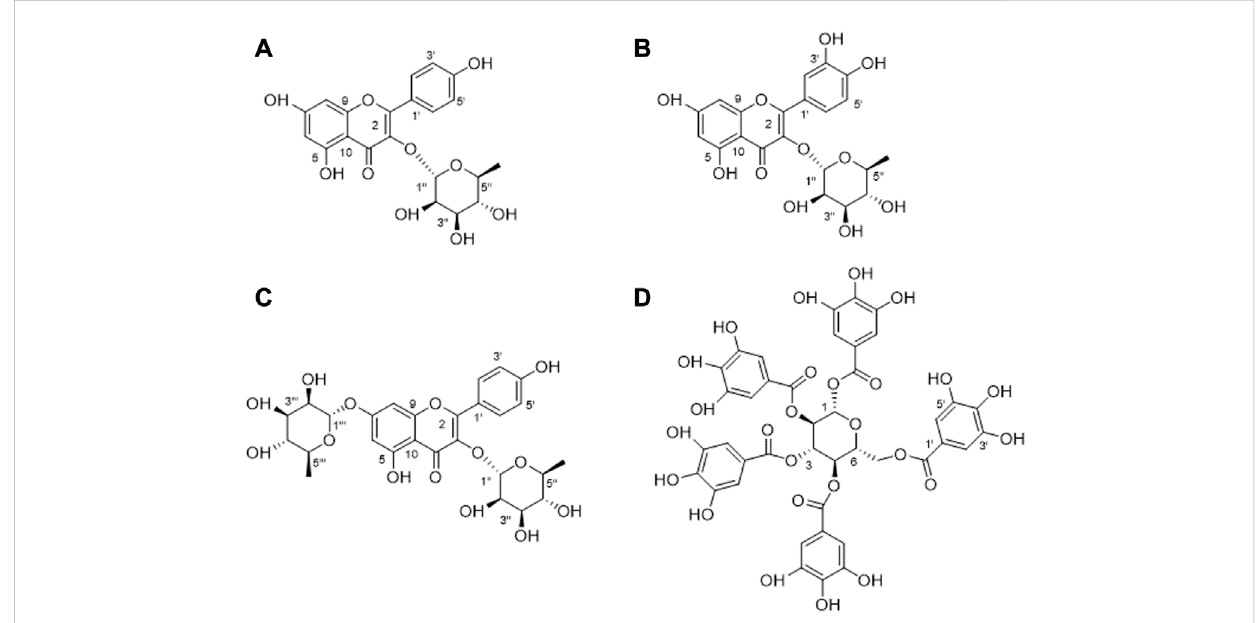
FIGURE 5 Structures of four compounds isolated from A. truncatum leaves. (A) Kaempferol-3- O - α -L-rhamnoside. (B) Quercetin-3- O - α -L- rhamnopyranoside. (C) Kaempferol-3,7- di - O - α -L-rhamnoside. (D) 1,2,3,4,6-Penta- O -galloyl- β